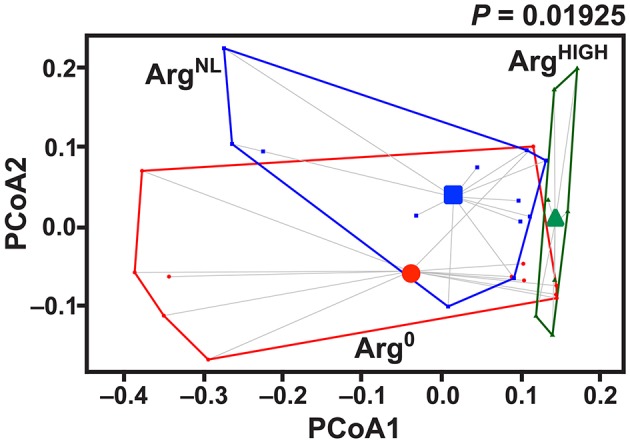
Effect of Arg on gut microbiota structure. Mice were fed for 7 days with AIN-76A ArgNL diet and then with the Arg0, ArgNL, or ArgHIGH regimens for 7 more days. After sequencing, the PCoA plot of microbial species abundance using the different Arg diet as grouping variable, based on the Bray-Curtis distances, was established. The significance between the groups was determined by PerMANOVA; n = 7–12 mice per group.